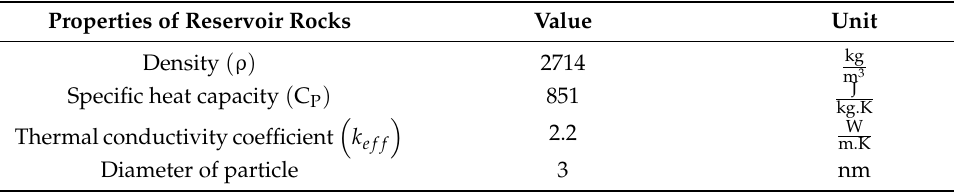
Table 9. Properties of reservoir rocks